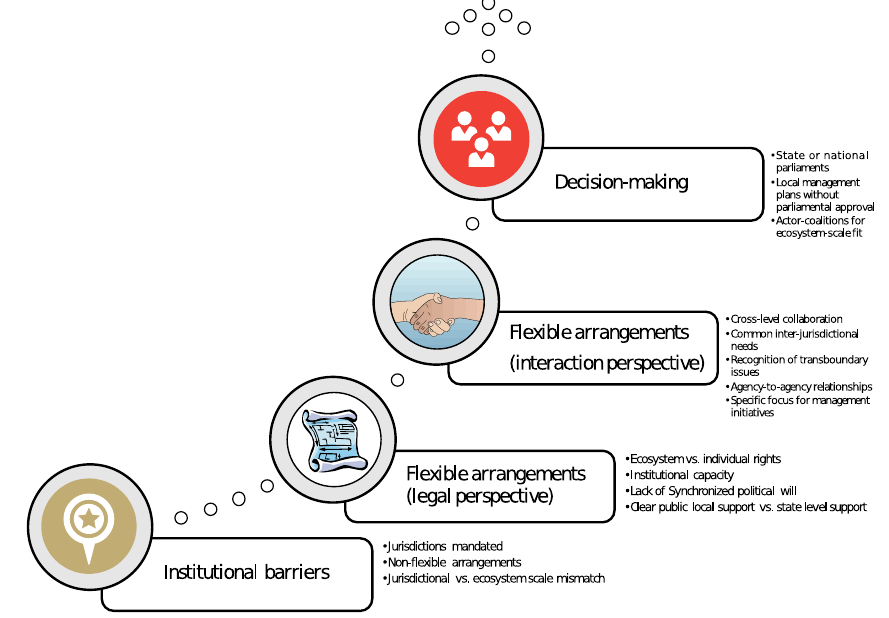
Figure 5. The process from identifying institutional barriers to decision ‐ making which resulted from stakeholder interactions.